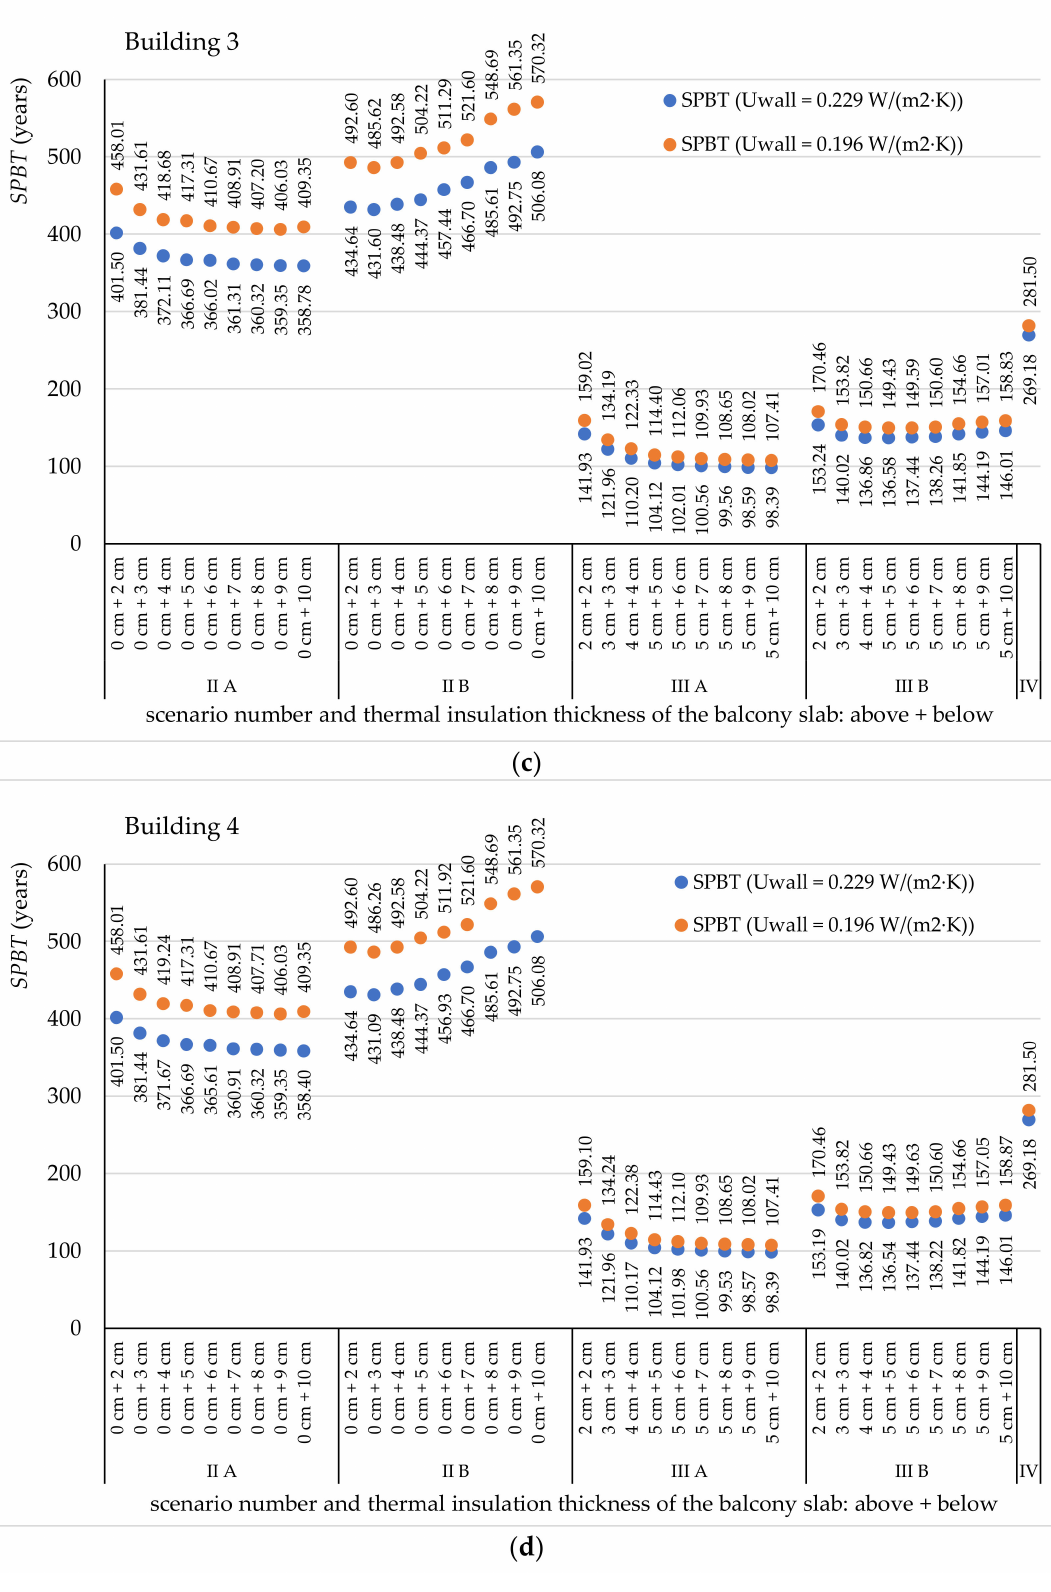
Figure 12. The Simple Payback Time for investment costs in different scenarios: ( a ) in building no. 1; ( b ) in building no. 2; ( c ) in building no. 3; ( d ) in building no.